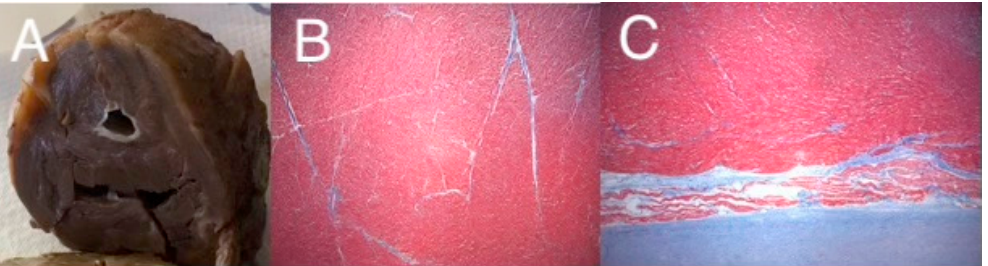
Figure 2. Gross specimen of an explanted heart from a patient with HLHS, with mitral stenosis and aortic stenosis ( A ), showing a diminutive LV chamber with endocardial fibroelastosis and a thickened LV wall, and trichrome staining from the LV free wall ( B ), and a luminal biopsy demonstrating severe EFE ( C ). Images graciously provided by Dr. Denise Malicki, Department of Pathology, Rady Children’s Hospital of San Diego.